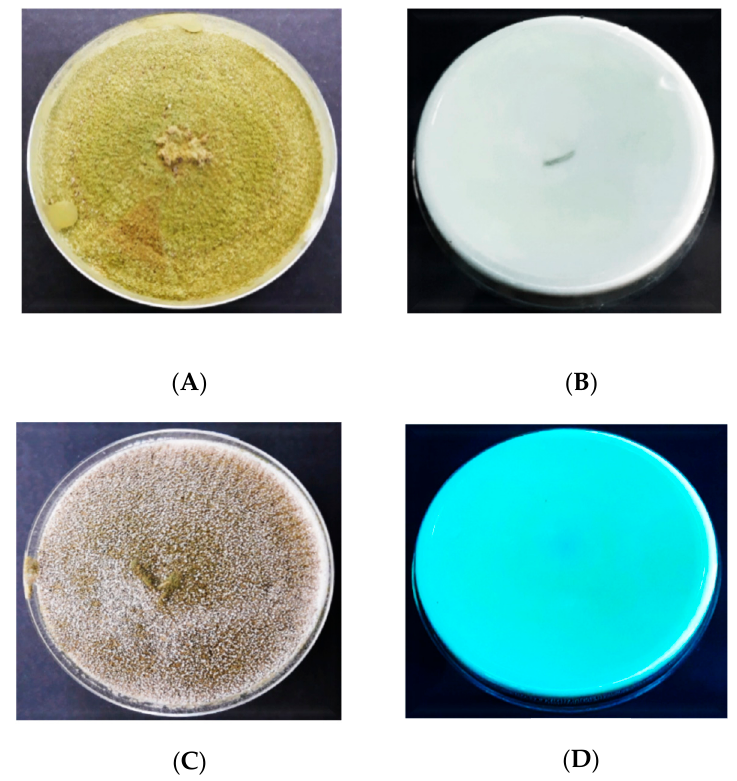
Figure 6. Colonies of the aflatoxigenic and non-aflatoxigenic isolates of A. flavus observed under UV light (365 nm); ( A ) = aflatoxigenic obverse, ( B ) = aflatoxigenic reverse, ( C ) = non-aflatoxigenic obverse, ( D ) = non-aflatoxigenic